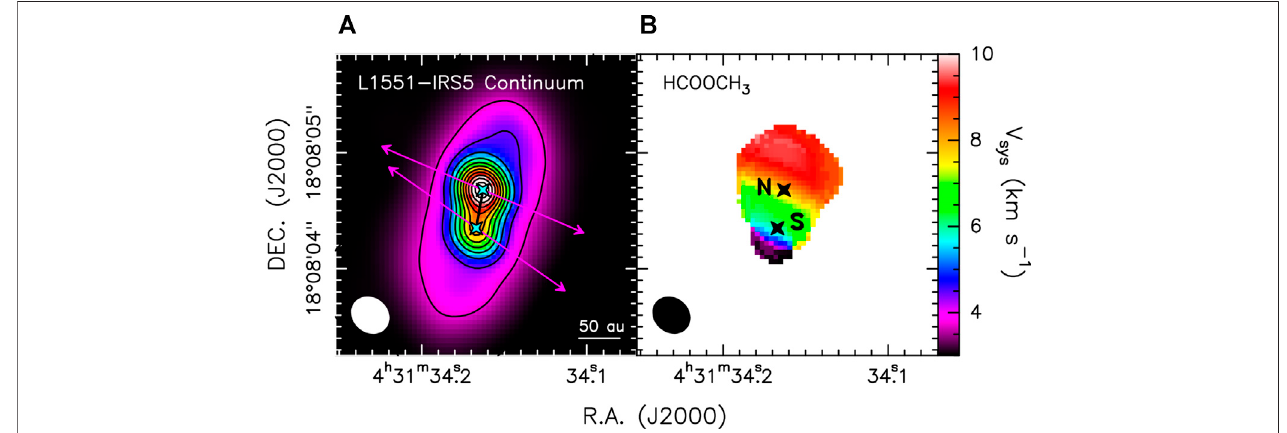
FIGURE 3 | L1551 IRS5 binary source, in Taurus. (A) : 1.3 mm dust continuum emission in color scale and black contours (Bianchi et al., 2020): the N and S protostars are revealed. (B) : Gas enriched in iCOMs around the IRS5 binary system, imaged on the 50 au scale. More speci fi cally, the intensity-weighted velocity (also calledmoment1)mapoftheHCOOCH 3 (18 4,14 – 17 4,13 )Aisshown,revealingavelocitygradientperpendiculartotheaxesoftheprotostellarjets(seethearrowsinthe (A) ) driven by N and S. The systemic velocities are +4.5 km s − 1 (S object) and +7.5 km s − 1 (N). The chemical enrichment occurs in rotating hot corinos around the protostars and/or in the rotating circumbinary disk.